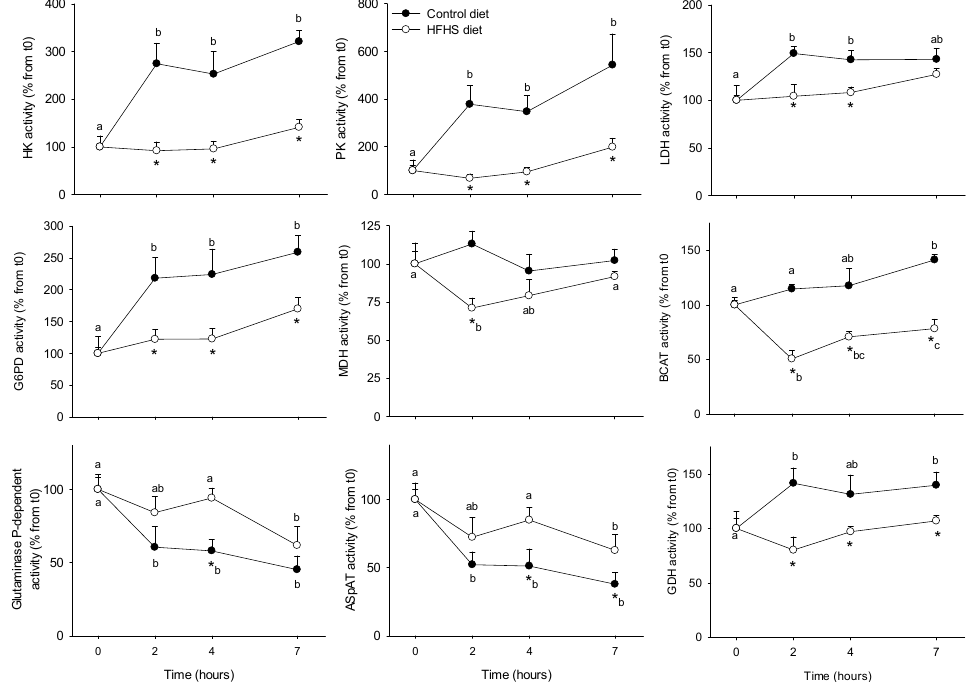
Figure 2. Hexokinase (HK), pyruvate kinase (PK), lactate dehydrogenase (LDH), glucose 6-phosphate dehydrogenase (G6PD), malate dehydrogenase (MDH), branched chain amino-acid transaminase (BCAT), glutaminase P-dependent, aspartate aminotransferase (AspAT) and glutamate dehydrogenase (GDH) alanine transaminase activities in PBMCs from Yucatan mini-pigs fed either a control or a high fat–high sucrose (HFHS) test meals. Enzyme activity units (mU) are defined as nmol of substrate converted to product, per min, at 37 °C and per mg protein. Results are expressed as means + SEM ( n = 5) and were analysed using a repeated measures two-way ANOVA test. Different letters indicate significant differences between sampling points for a given meal test. * Significantly different for a given sampling point between the control and the HFHS meals ( p < 0.05). PMBC: peripheral blood mononuclear cell.